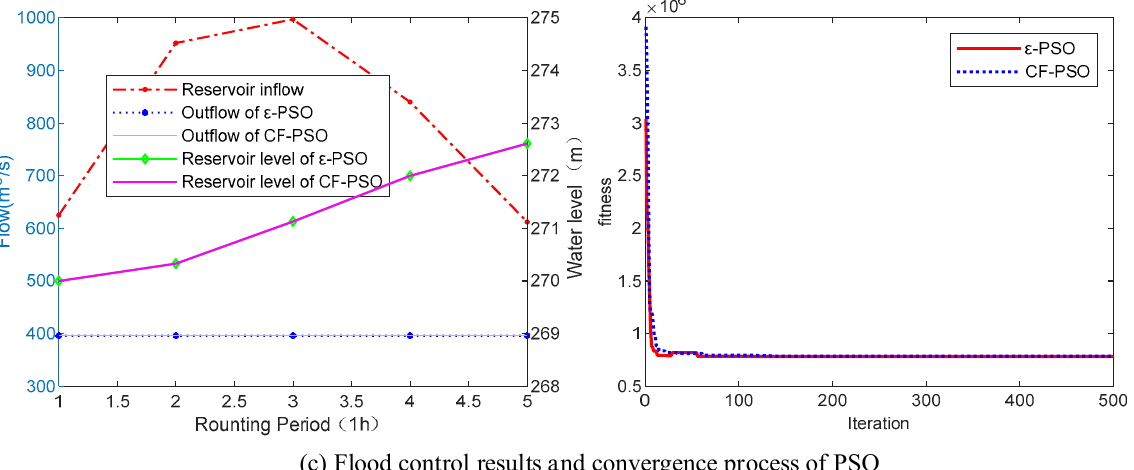
Figure 3. Comparison of operation processes of different algorithms in Shafan Reservoir.